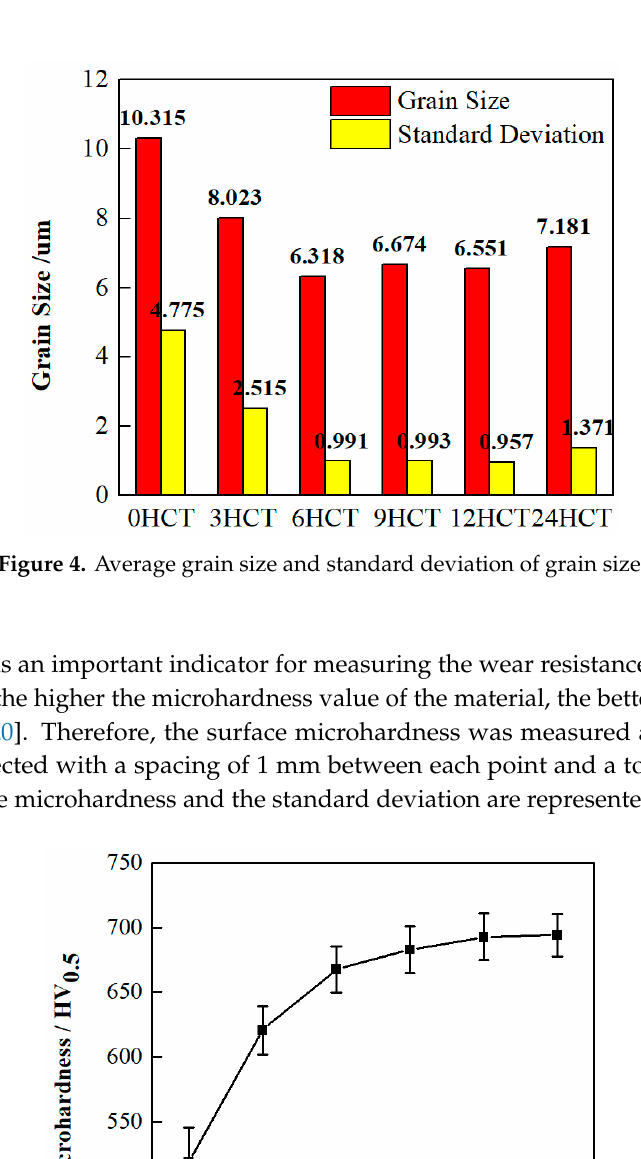
Figure 3. Microstructure of cladding coatings: ( a ) 0 HCT; ( b ) 3 HCT; ( c ) 6 HCT; ( d ) 9 HCT; ( e ) 12 HCT; ( f ) 24 HCT.